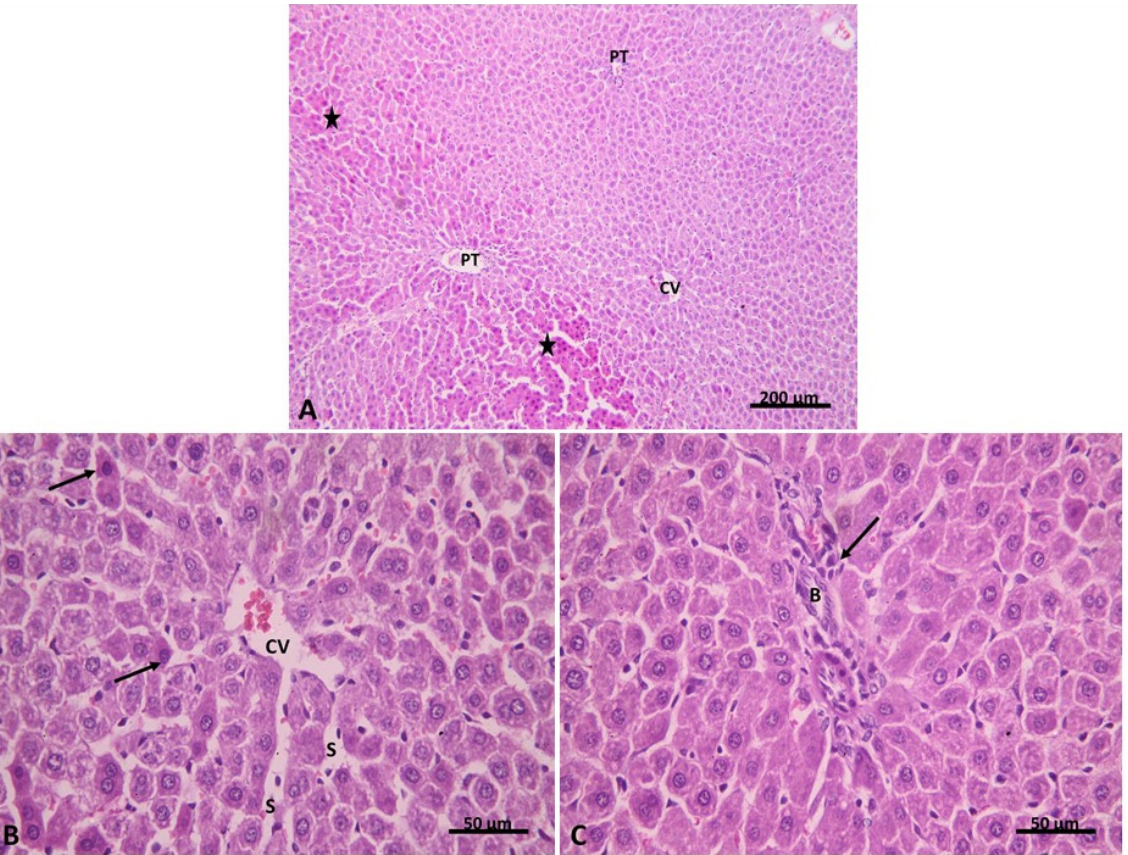
Figure 8. ( A ) showing restoration of the hepatic architecture with few focal areas of deep acidophilic hepatocytes (*). ( B ) Group IV. H&E x100 showing congested central vein (CV). Few hepatocytes are seen with deep acidophilic cytoplasm and small dark nuclei ( ↑ ), while the rest of the hepatocytes are seen more or less similar to the control. Blood sinusoids are seen dilated in some areas (S). ( C ) Group IV. H&E ×400 showing portal tract less expanded than group II with an apparent decrease in bile duct (B) proliferation. Cellular infiltration can be seen ( ↑ ). Group IV. H&E ×400.